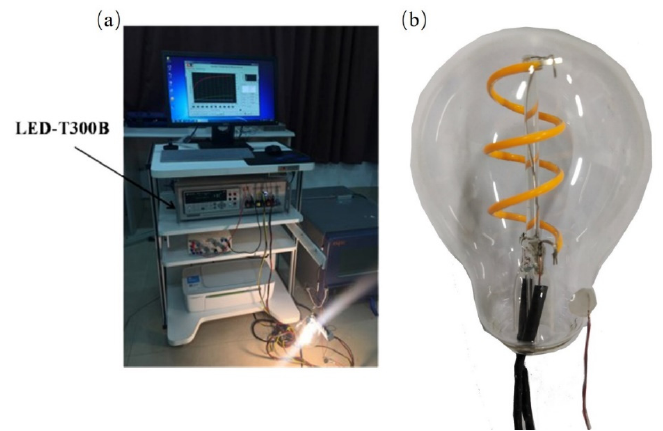
Figure 2. ( a ) Junction temperature testing instrument (LED-T300B). ( b ) LED filament bulb with Figure2. ( a )Junctiontemperaturetestinginstrument(LED-T300B).( b )LEDfilamentbulbwiththermocouple. Appl. Sci. 2020 , 1, x